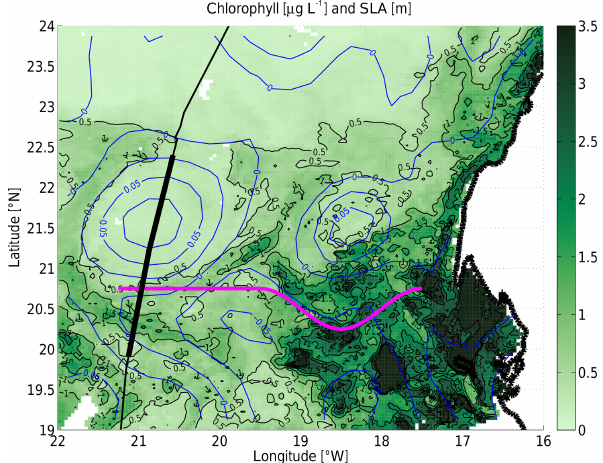
Figure 3. Map of satellite-based chlorophyll concentration (in micrograms per liter; OC-CCI v3.1 product) as color with sea level anomaly (in meters; SSALTO/DUACS SSH L4) as blue con- tours. The chlorophyll is an 8d average centered on 13 June 2018 12:00UTC, and the SLA is a 7d average centered on 13 June 2018 00:00UTC, i.e., approximately 2 weeks after the TRIAXUS